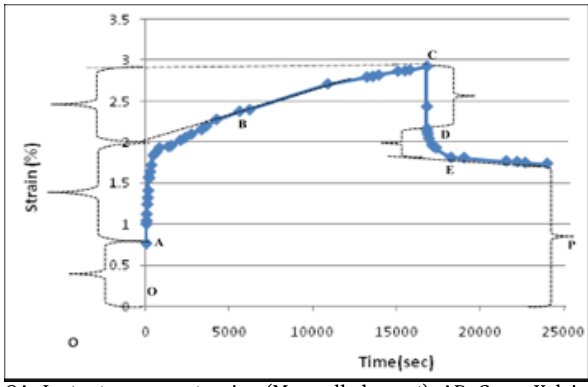
Figure 2: Creep and creep recovery behavior of epoxy